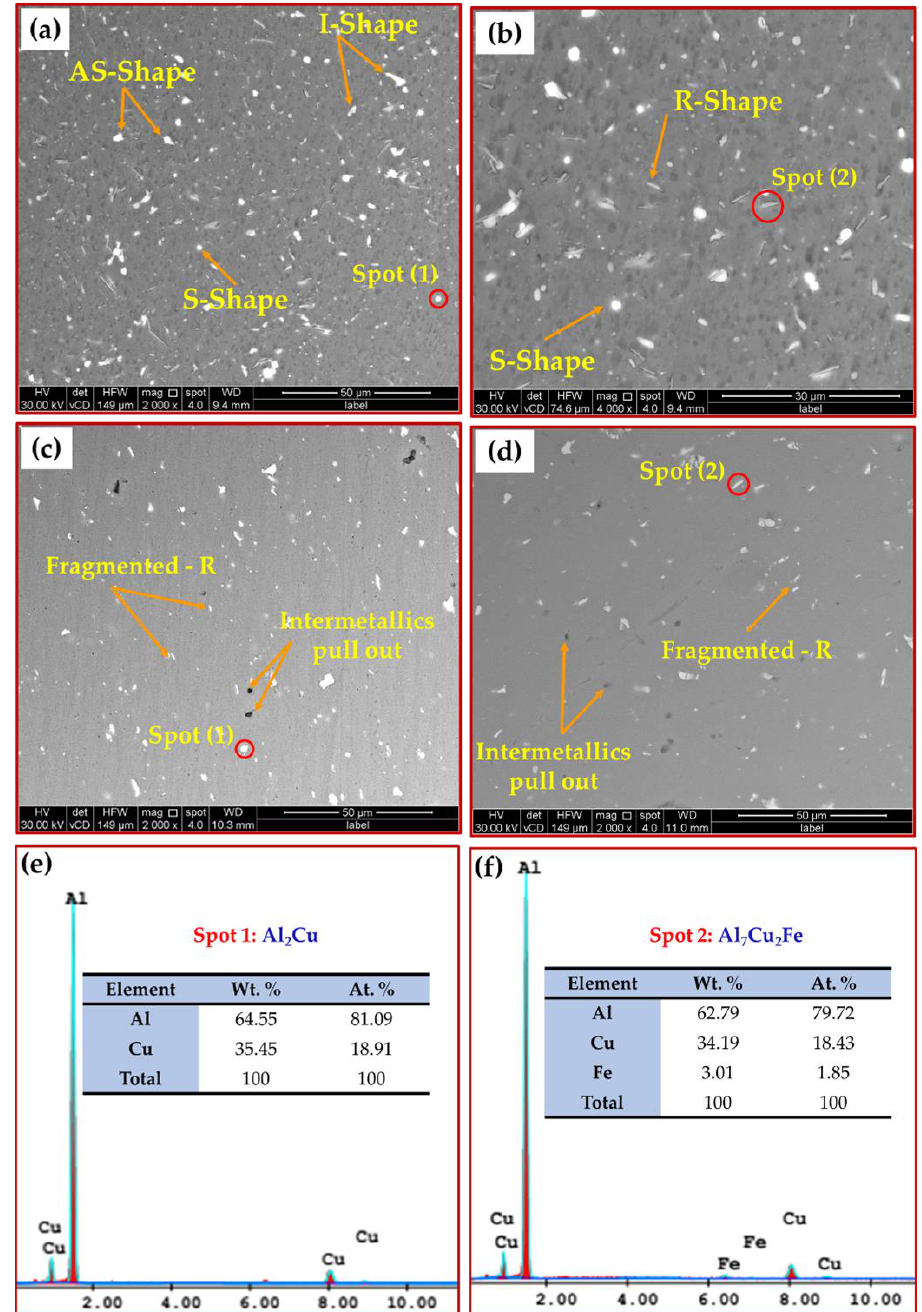
Figure 13. ( a ) Low and ( b ) high magnification SEM images of AA2011-T6 BM, ( c ) deposited matrix, and ( d ) AA2011/nano Al 2 O 3 composite; ( e , f ) EDS analyses of spot 1 and spot 2, respectively, in ( a – d ).